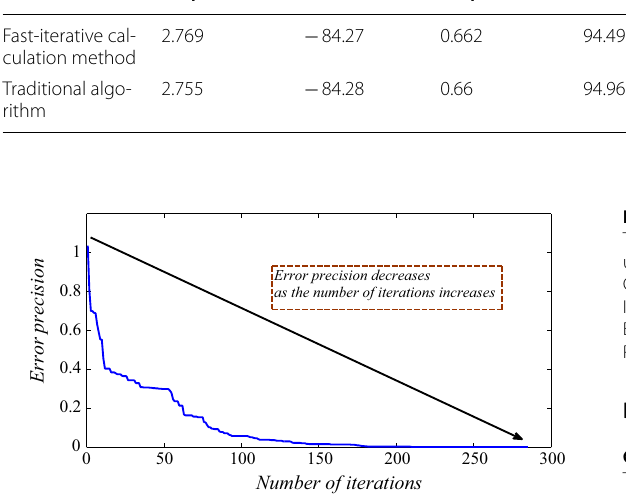
Fig. 11 Trend of error of the fast‑iterative calculation method